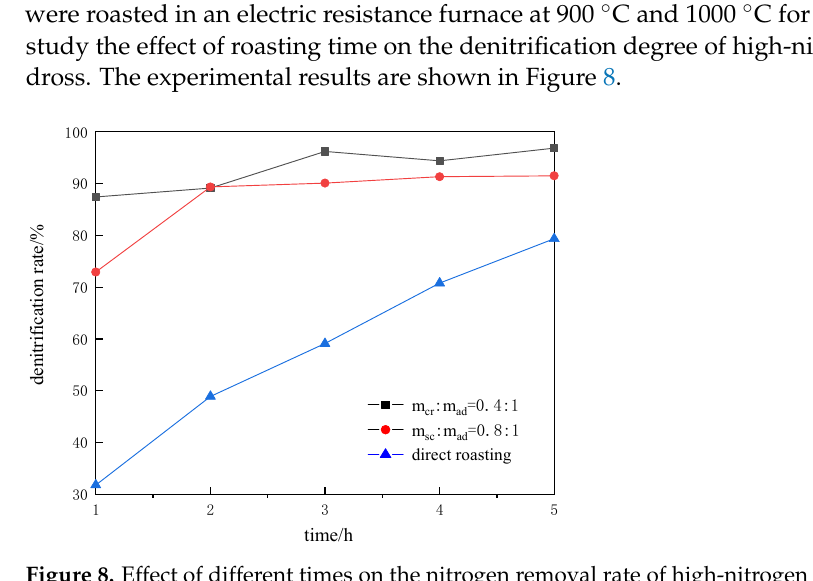
time/h Figure 8. Effect of different times on the nitrogen removal rate of high-nitrogen aluminum dross.